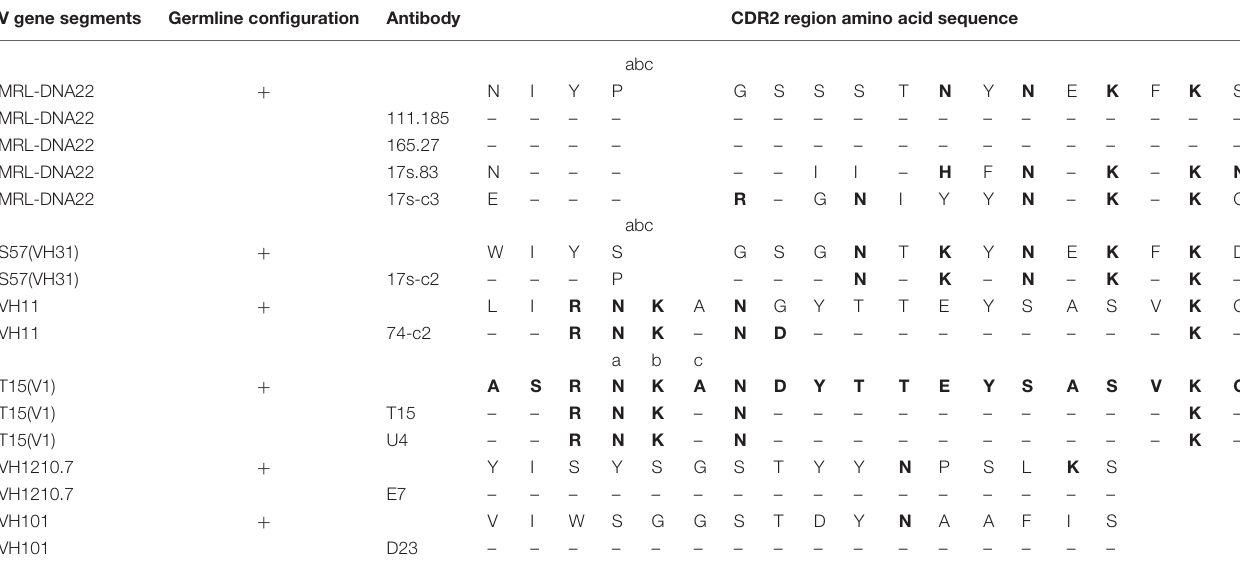
TABLE 2 | Sequence alignment for CDR2 regions of the V gene